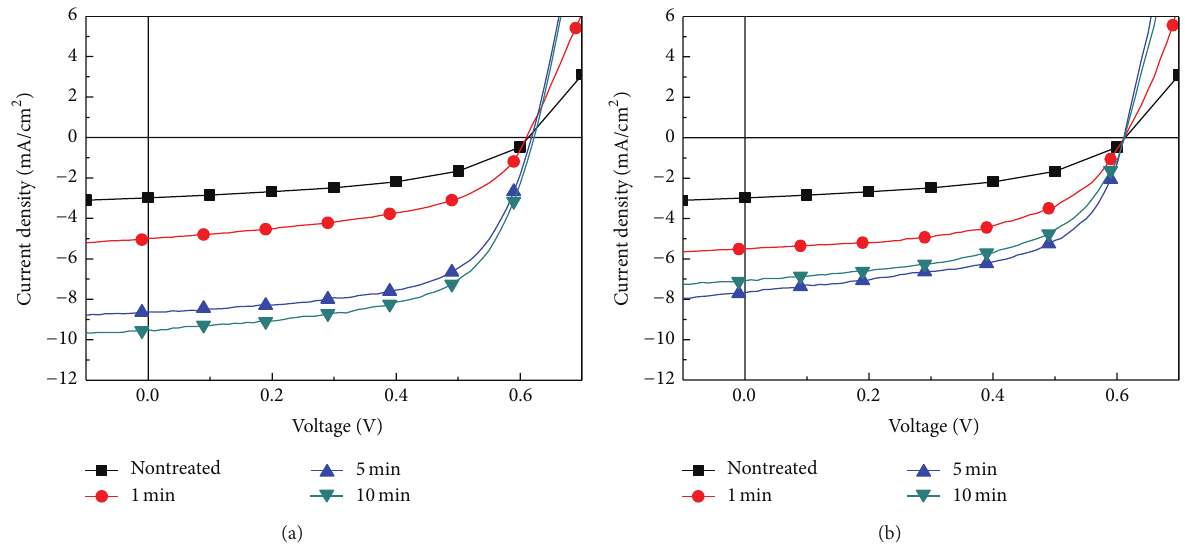
Figure1: 𝐽 - 𝑉 characteristicsoforganicphotovoltaicdeviceswith(a)thermalannealingprocessand(b)laserannealingprocessunderdifferent